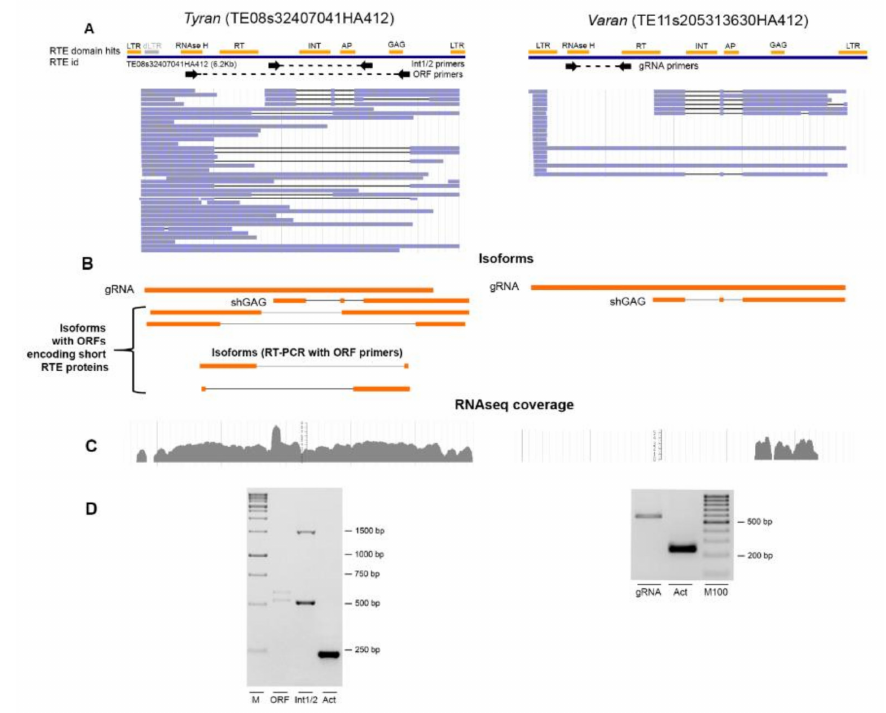
Figure 6. Detection of RTE transcripts by nanopore direct RNA sequencing (DRS). ( A ): Organization of the main protein domains and LTRs for Tyran (exRTEs, left) and Varan (RTE, right). DRS reads mapped to the genomic sequences of these RTEs are colored blue. Primer positions used for isoform verification are depicted below these. ( B ): Isoform composition for Varan and Tyran based on DRS read mapping and alignment of cDNA sequencing obtained with ORF primers (only for Tyran ). ( C ): RNAseq (leaves) read coverage plot. ( D ): Results of RT-PCR with primers designed on Varan and Tyran isoforms and Actin ( Act ) in RNA extracted from 5-day-old